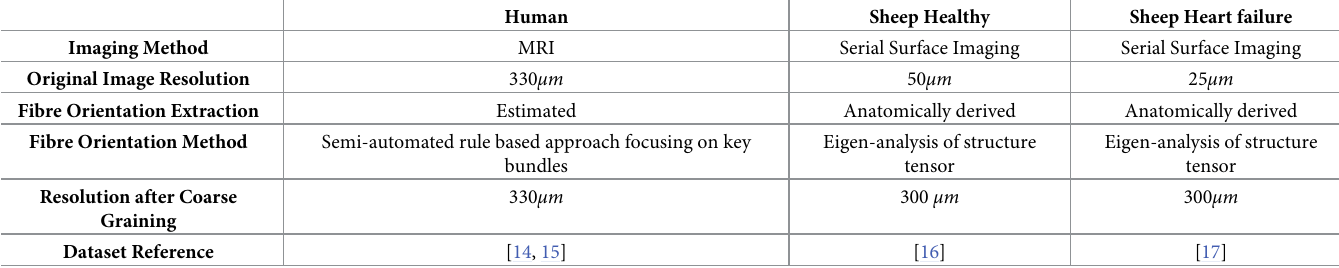
Table 1. Summary information for the three atrial fibre orientation